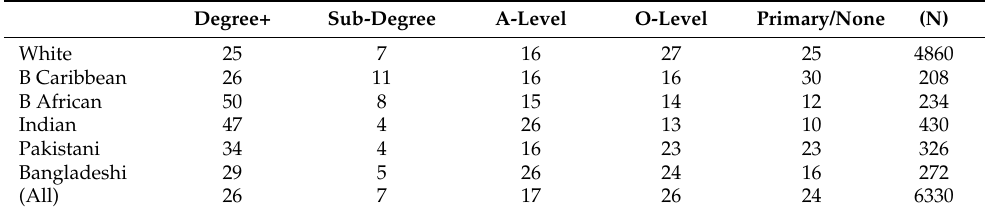
Table 4. Educational distribution by ethnicity (percentage by row).